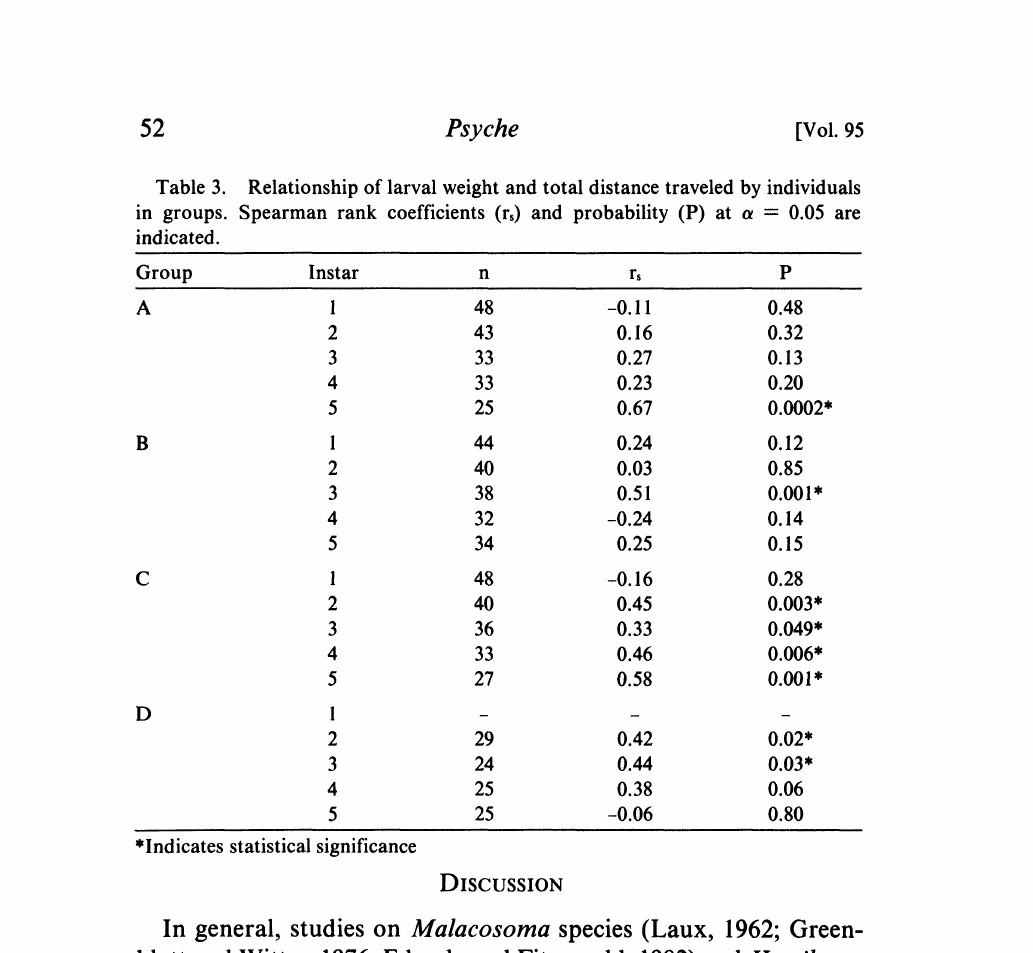
Table 3. Relationship of larval weight and total distance traveled by individuals in groups. Spearman rank coefficients (rs) and probability (P) at a 0.05 are